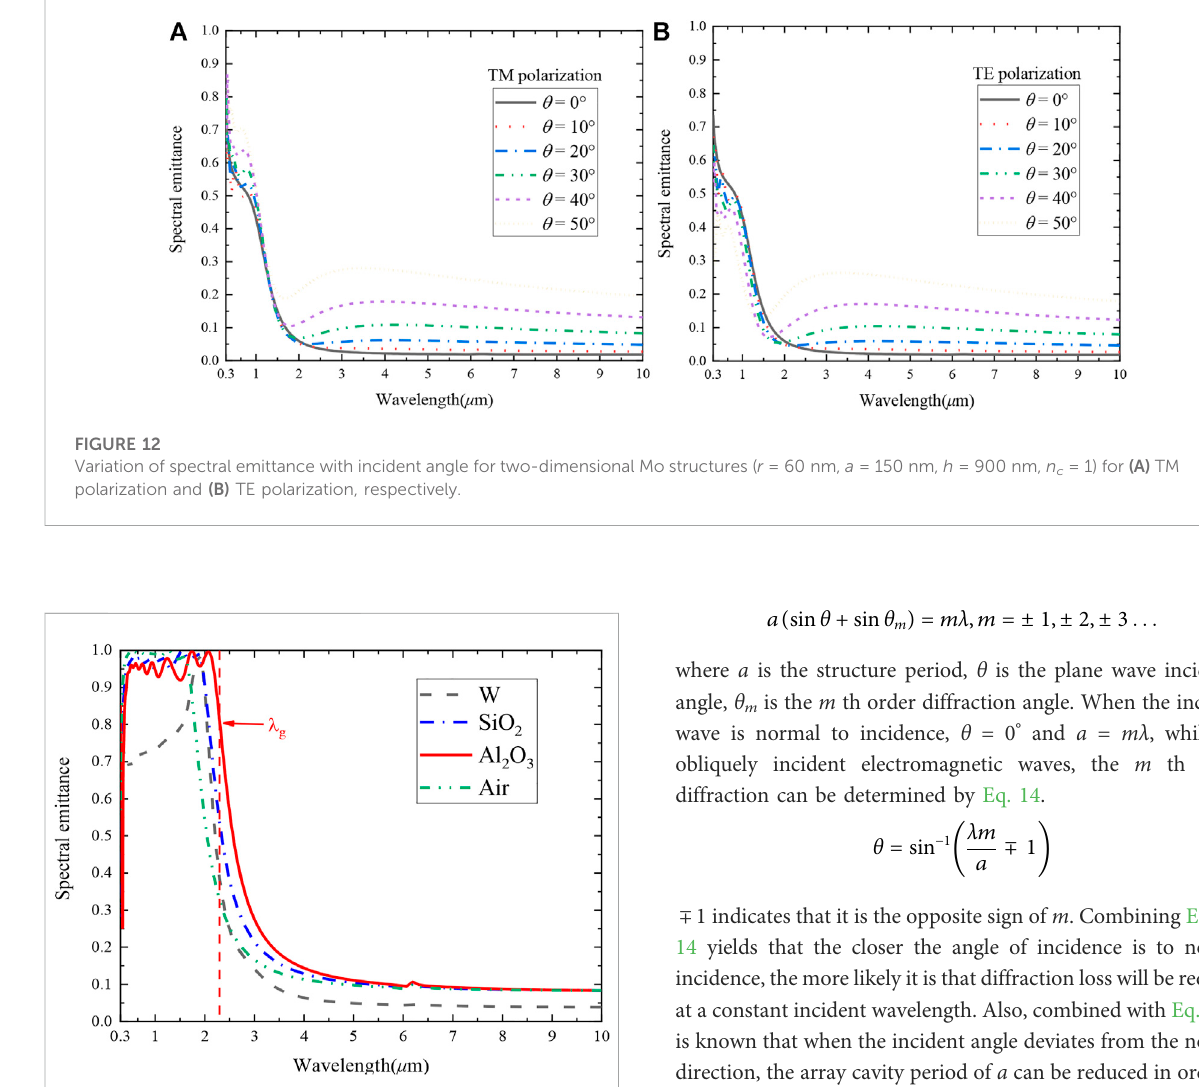
FIGURE 13 With other parameters fi xed ( LP = 10, h = 900 nm, r = 60 nm, a = 150 nm, d M = 10 nm, d D = 80 nm), the spectral emittance of thestructurevarieswiththe fi llingmedium(W,SiO 2 ,Al 2 O 3